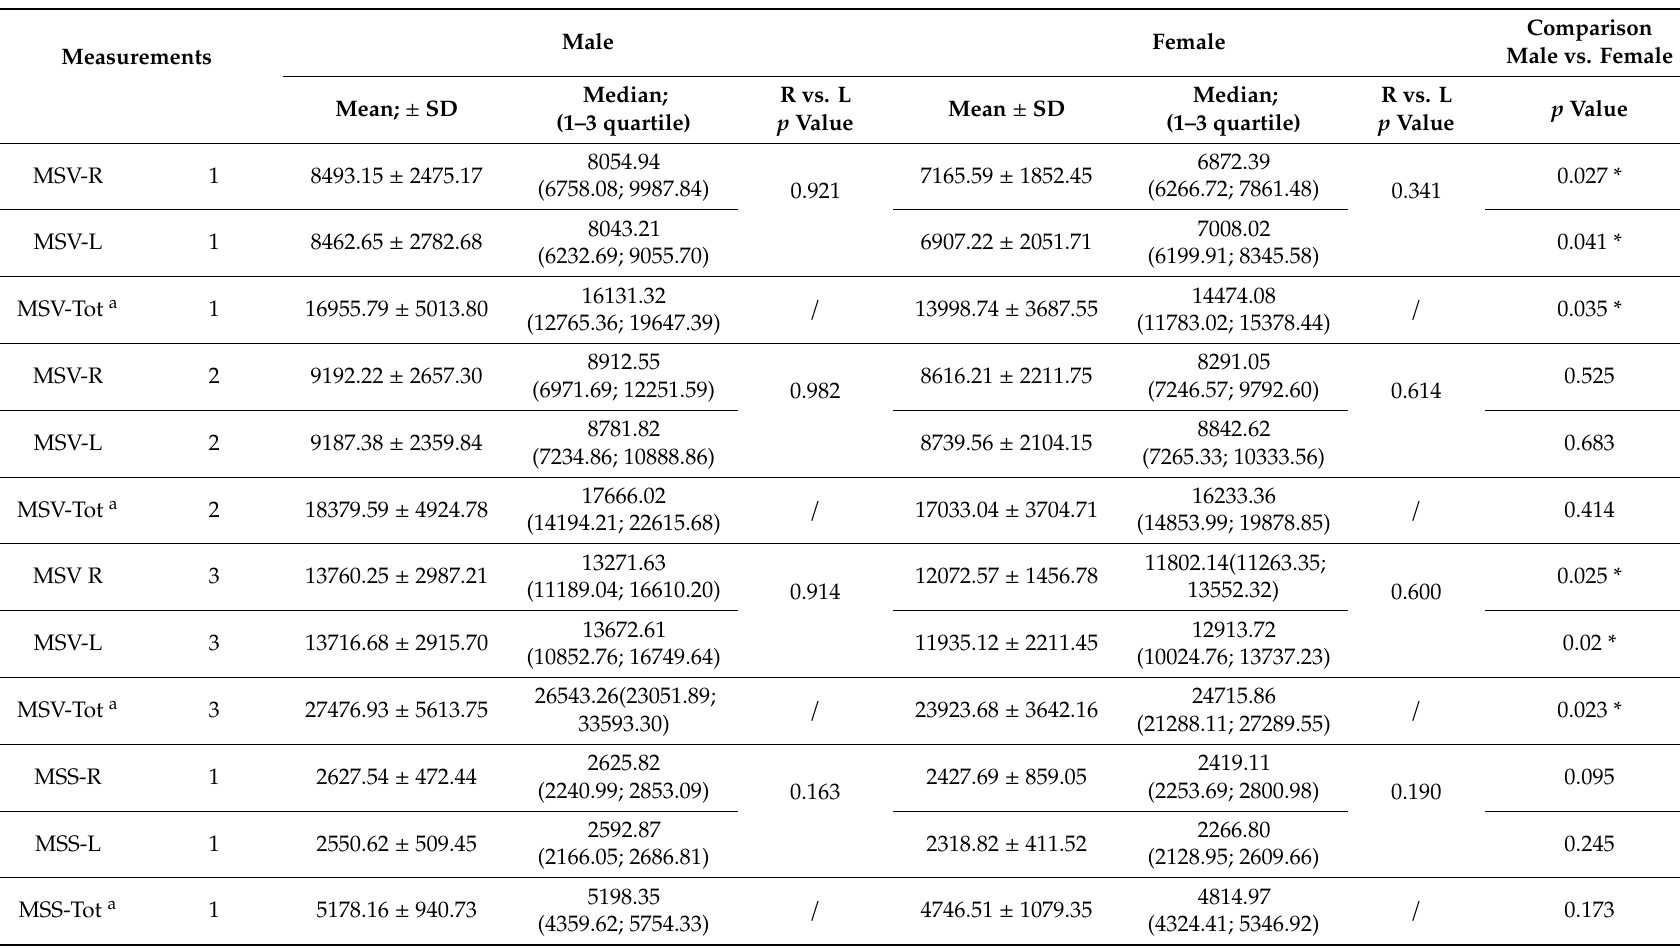
Table 1. Descriptive statistics for maxillary sinus parameters; Wilcoxon tests between right and left side and Mann–Whitney test to compare Males vs. Females.